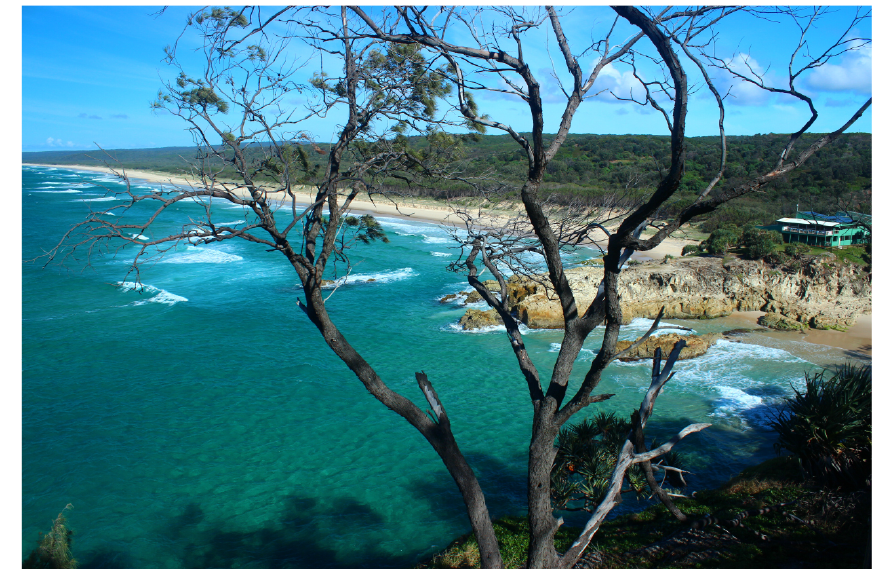
Figure A2. The North Stradbroke Island east coast at Point Lockout at the northern tip of the island looking south-west. The dunes in the background are covered by typical native eucalypt